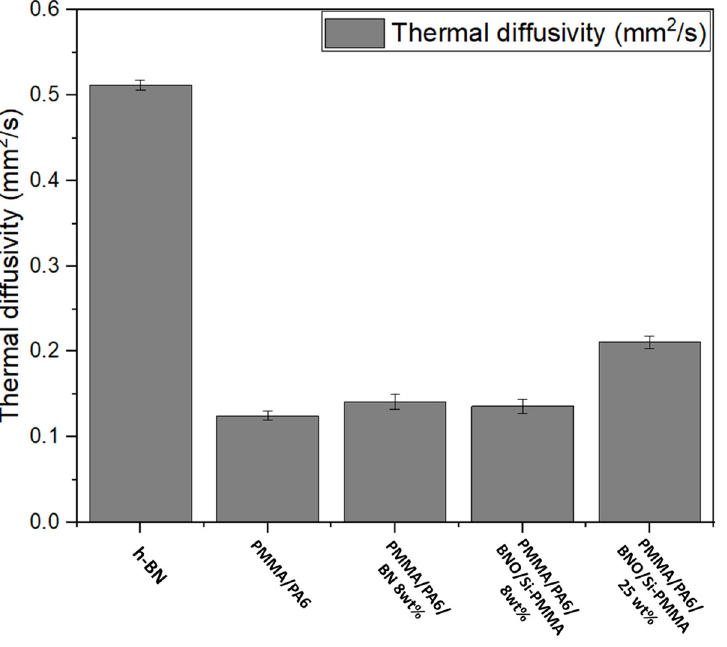
Figure 15. Thermal diffusivity of h-BN, PMMA/PA6, and PMMA/PA6/h-BN composites with different loading fillers.